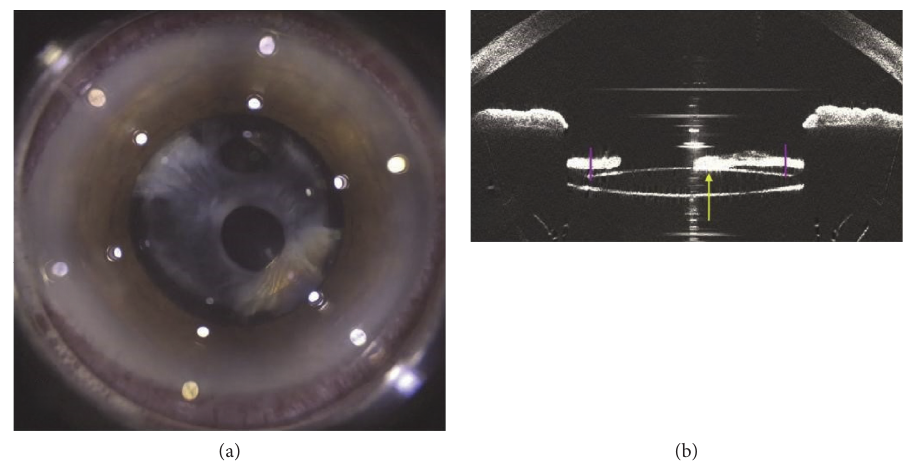
Figure 2: Femtosecond laser system (a) and LenSX ® anterior optical coherence tomography (OCT) (b) allow the visualization of fibrotic adherence between anterior capsule and the anterior surface of the IOL .